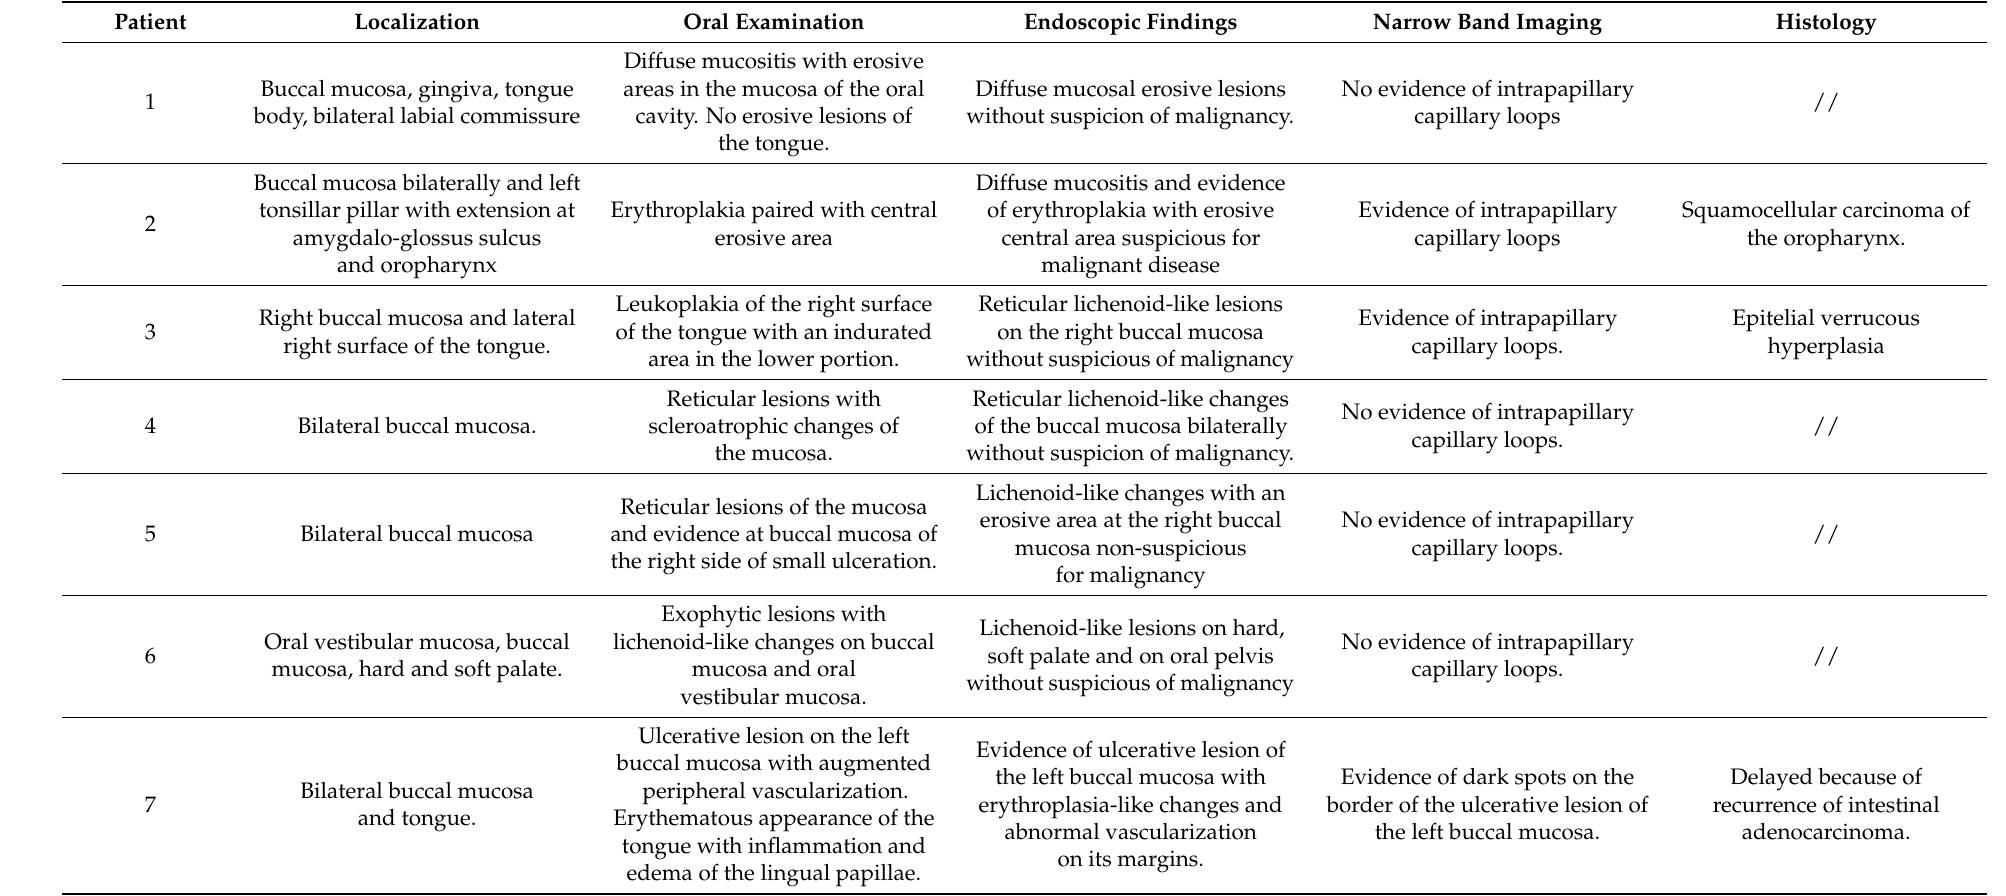
Table 3. Summary of oral and endoscopic